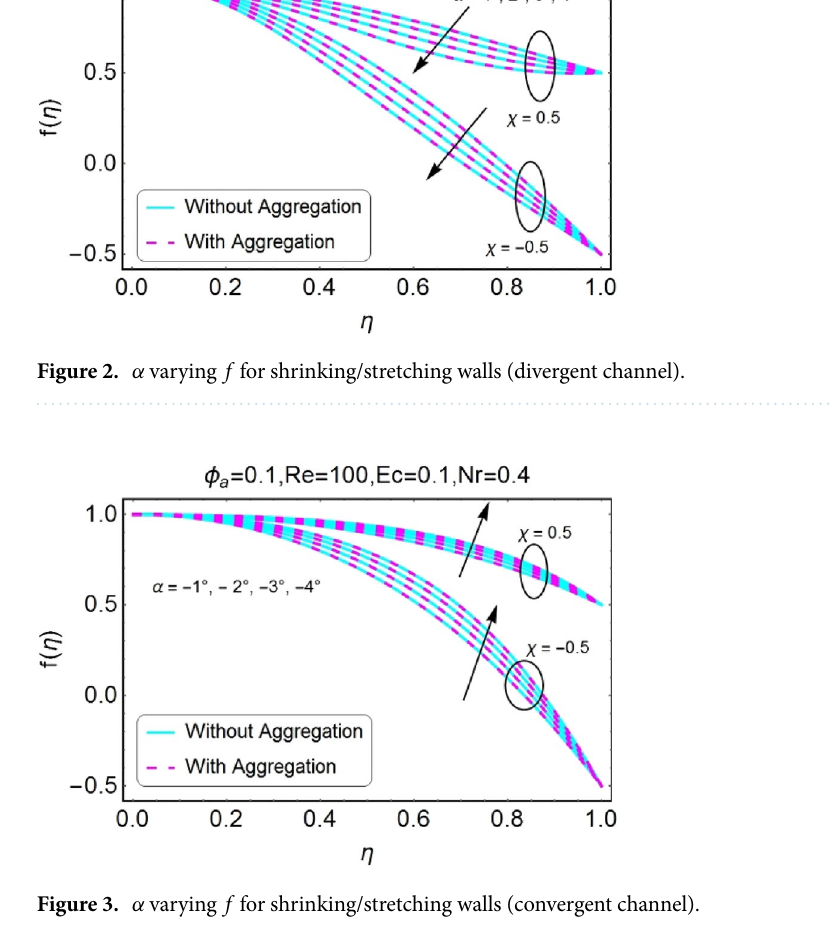
Figure 3. α varying f for shrinking/stretching walls (convergent